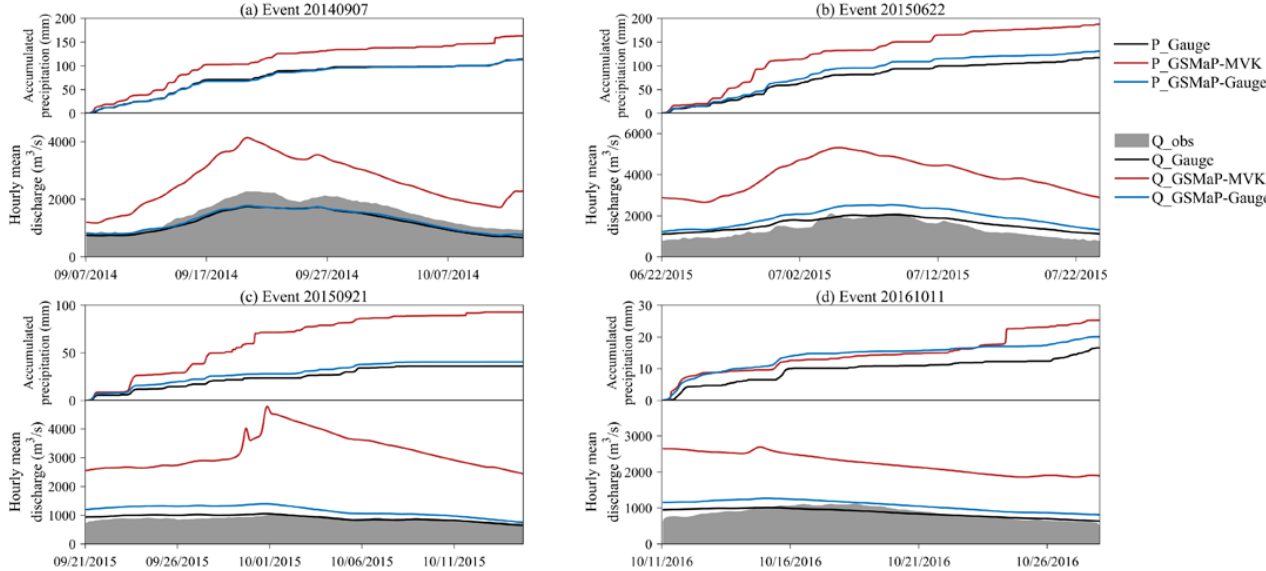
Figure 12. Observed and simulated hourly hydrographs of the four historical flood events in 2014–2016 at the Tangnaihai hydrological station using the rain-gauge-, GSMaP-MVK-, and GSMaP-Gauge-based precipitation data inputs (the variables shown in this figure are as same as those in Figure 8). Table 4. Performance of flood event simulations at the Tangnaihai streamflow station using the rain-gauge-based precipita- tion data and the five GSMaP SPPs as model inputs. Flood